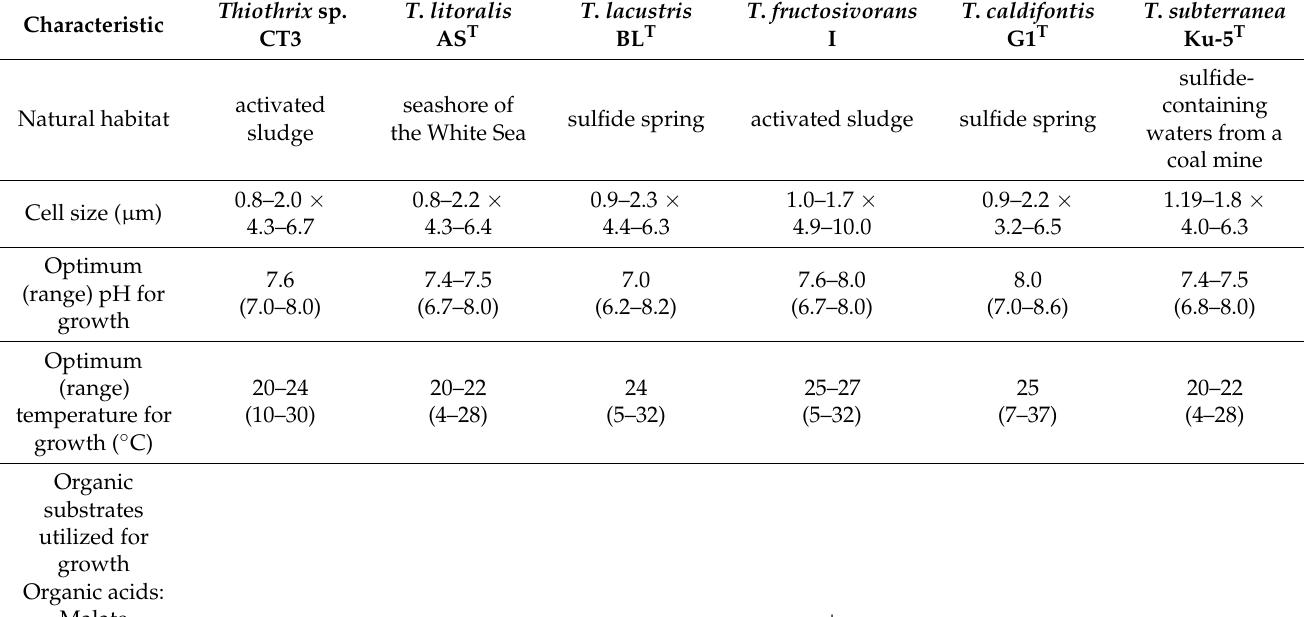
Table 1. Differentiating characteristics between phylogenetically related species from the genus Thiothrix (Clade I). All strains utilize acetate, lactate and pyruvate. Glyoxylate, glycolate, benzoate, salicylate, methanol, isopropanol (propan-2-ol), glycerol, lactose, D-galactose, D-(+)-glucose, D- mannose, serine, lysine, tryptophan, methionine, tyrosine, ornithine, glutamine and alanine do not support the growth of all strains. All strains are capable of chemolitoautotrophic growth with thiosulfate and bisulfide. All strains are capable of respiration of nitrate to nitrite. No strains hydrolyze gelatin or starch. All strains are catalase-negative. None of the strains grow at 3% NaCl. Thiothrix litoralis AS T is able to survive with up to 3% NaCl in the medium. The major fatty acids for all strains are C 16:1 ω 7 , C 16:0 , C 18:1 ω 7 . Data are from